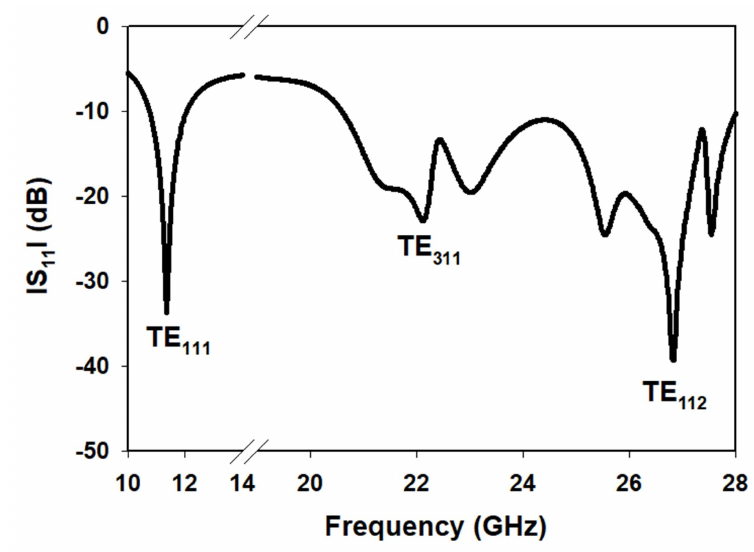
Figure 2. Simulated S 11 of the slot-fed hemispherical